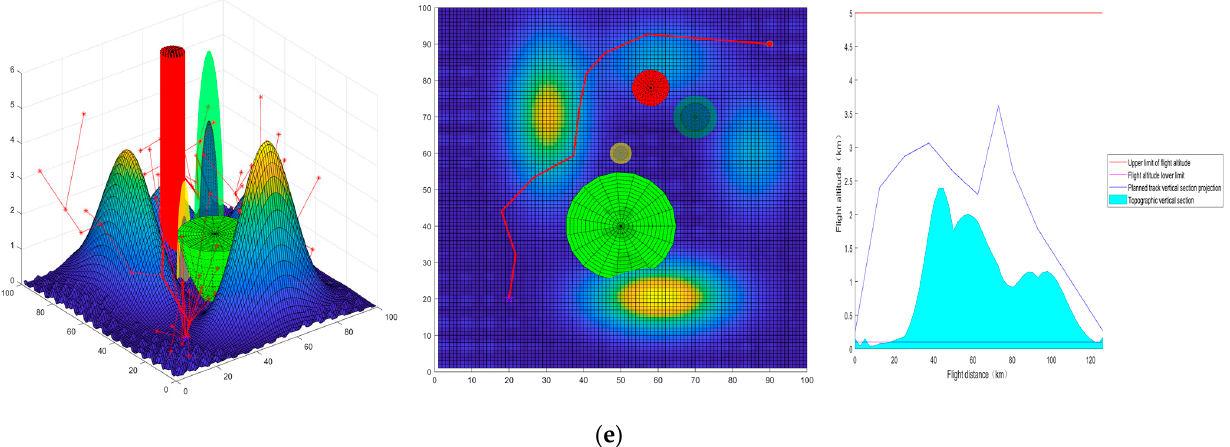
Figure A3. When N = 4, the comparison experiment of the route planning algorithm’s planning result, top view, and altitude change curve. ( a ) Grid-based route planning with the A* algorithm, ( b ) A* algorithm route grid point-based planning, ( c ) Grid-based route planning with Lazy Theta* algorithm, ( d ) Grid point-based Lazy Theta* route planning, and (e ) RRT* route planning using 12.5-steps. (3) N = 5. When the grid level is 5, the route planning effect is depicted in Figure A4.